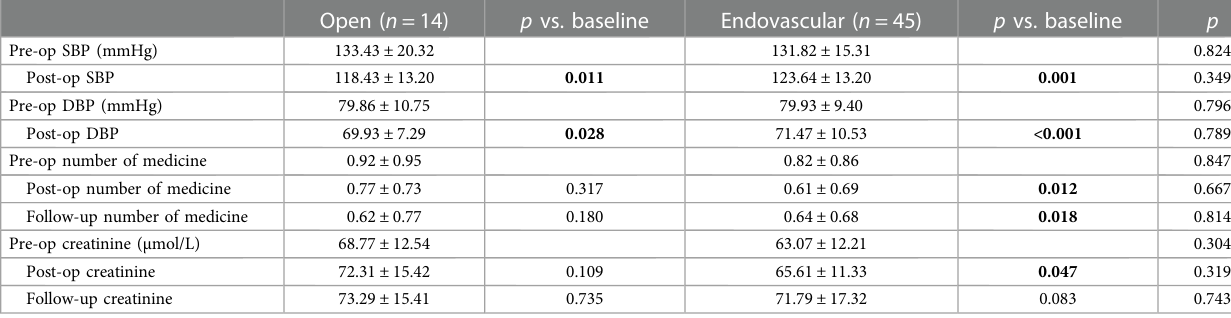
TABLE 2 Change of blood pressure and renal function for RAA